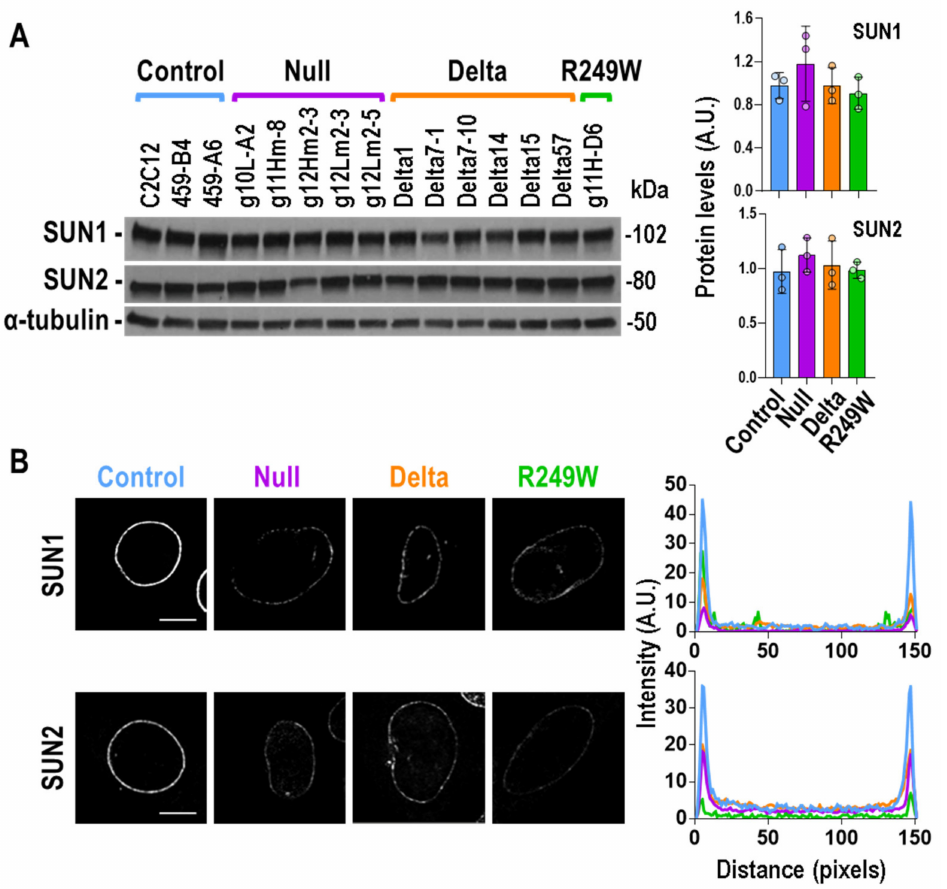
Figure 5. SUN1 and SUN2 protein levels and sub-cellular localization in Lmna exon 4 mutant myoblasts. ( A ) Total amount of SUN1 and SUN2 proteins was determined by Western blot. One of the three biological replicates is shown. The rest of the Western blots are shown in Figure S5. Quantification, by mutant type, of SUN1 and SUN2 signals for the three independent analyses is shown in the graphs on the right. Bars are mean ± SEM, n = 3. No significant di ff erences were detected when mutants were compared with controls using a two-tailed, unpaired Student’s t -test. Representative, single, confocal, images of SUN1 ( B ) and SUN2 ( C ) detected by immunostaining are shown. A decreased nuclear envelope signal was observed in null, delta, and R249W mutants. Scale bar = 8 µ m. Right plots show average fluorescence intensity across nuclei by mutant type (control (blue): three clones; null (purple): five clones; delta (orange): six clones; R249W (green): one clone; n = 5 nuclei per clone). Peaks at both ends of the plot represent peripheral staining. Representative images for SUN1 and SUN2 in all the clones are shown in Figures S9 and S10,